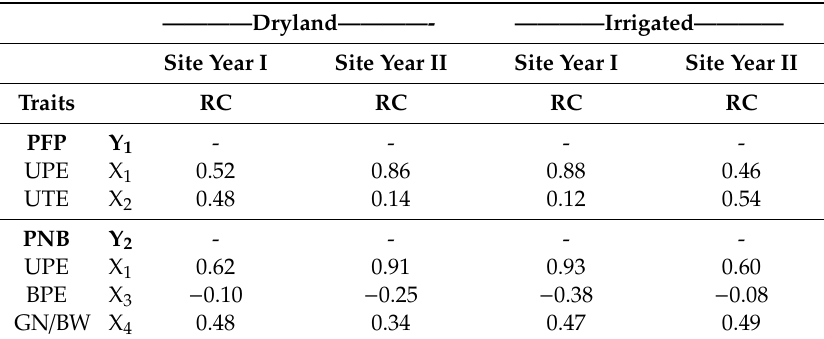
Table 3. Contribution (relative contribution in regression) of parameters related to the variation in PFP and PNB.